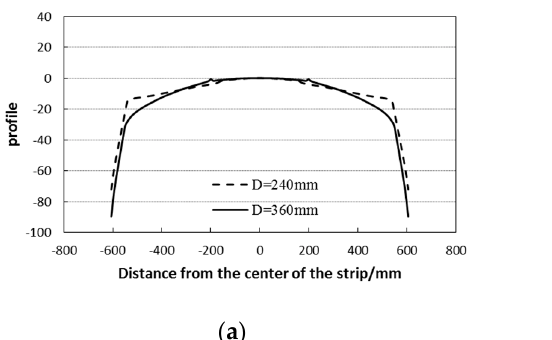
Figure 8. Comparison of profile calculation results with different work roll diameters: ( a ) No work roll contour; ( b ) with work roll contour.